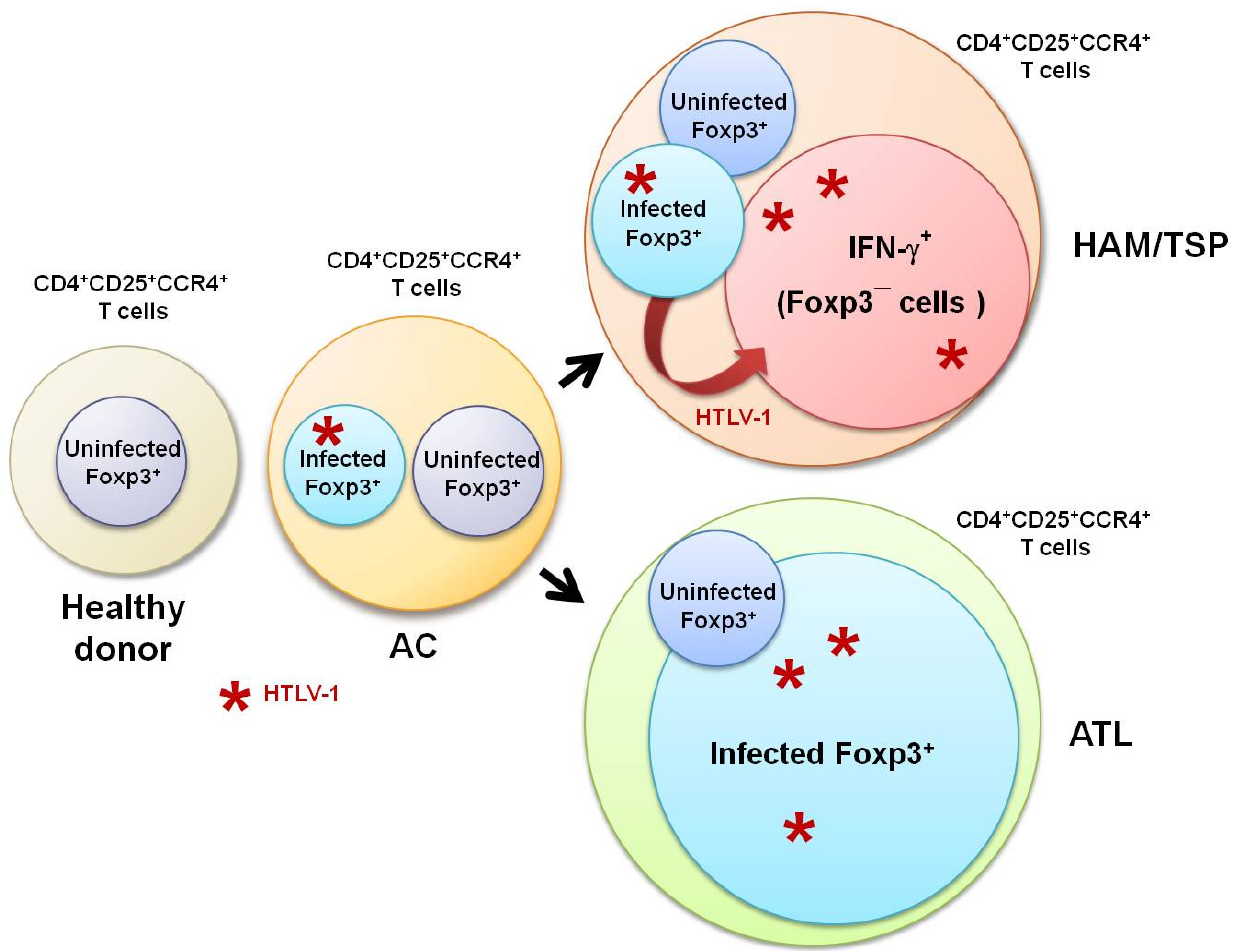
Figure 4. Scheme of proportion of each cellular component in CD4 + CD25 + CCR4 + T cells of healthy donors, asymptomatic carriers (AC), and patients with HAM/TSP or ATL. Although the proportion of Foxp3 + cells among the CD4 + CD25 + CCR4 + T cells is lower in HAM/TSP patients, the overall number of CD4 + Foxp3 + cells in HAM/TSP patients is higher than that in healthy donors. In ATL patients, the majority of CD4 + CD25 + CCR4 + T cells are Foxp3 +